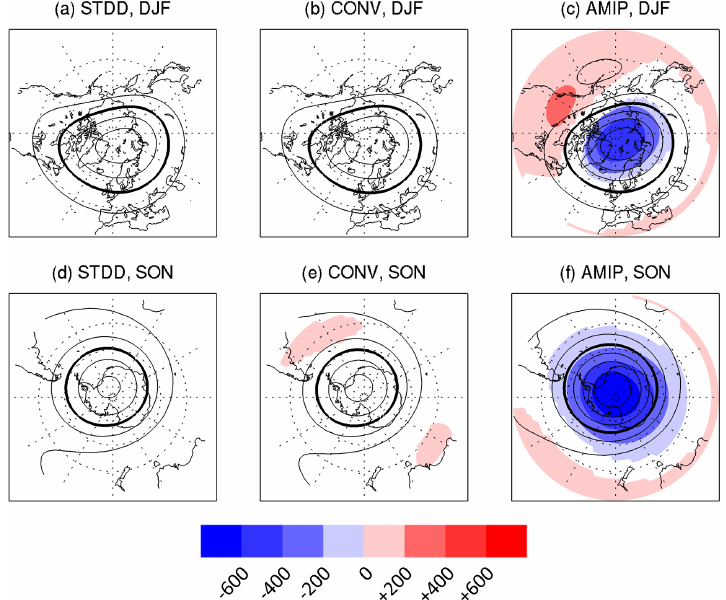
Figure 2. Same as in Fig. 1, but for the climatological mean 10hPa height. The contour interval is 500m. Thick contours denote 30000m.